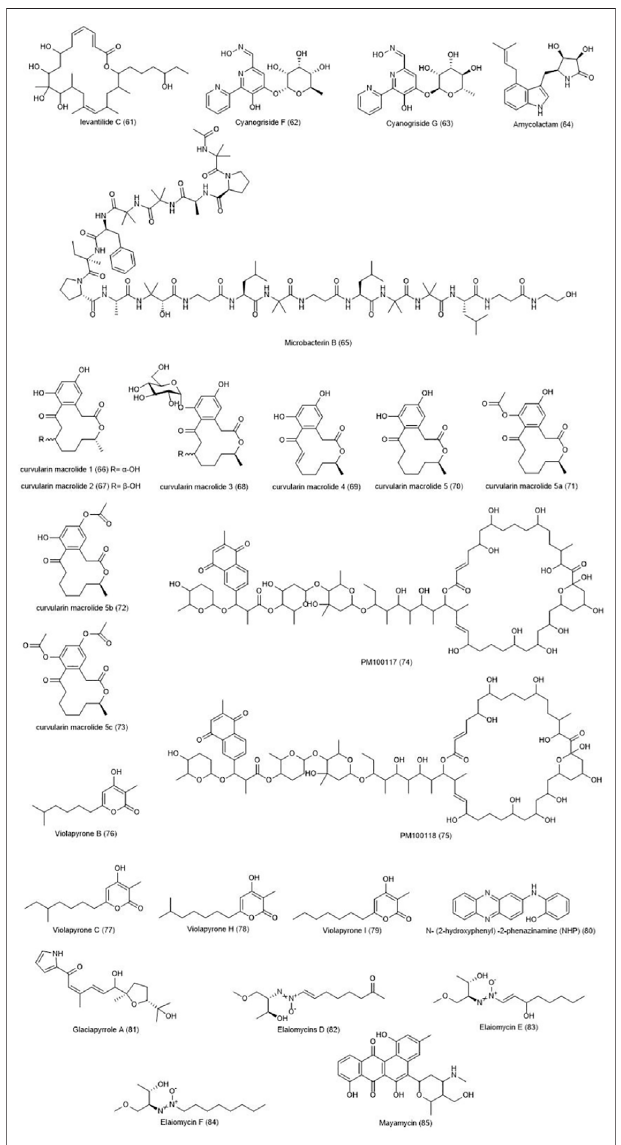
FIGURE 3 | Chemical structures of NPs 61 –